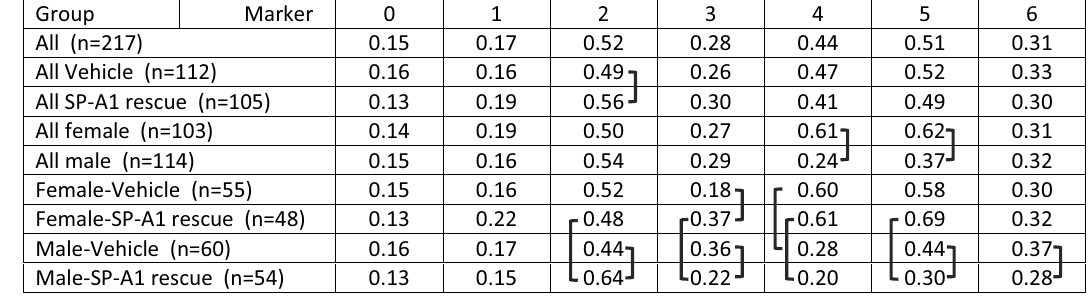
Table 4. Comparison of group marker means. For each group indicated in the left-hand column of the table, the number of cells is given. The mean levels of each marker were calculated and listed in the numbered columns. A series of pairwise comparisons were done and significant differences (adjusted p value < 0.05) are indicated by the brackets.